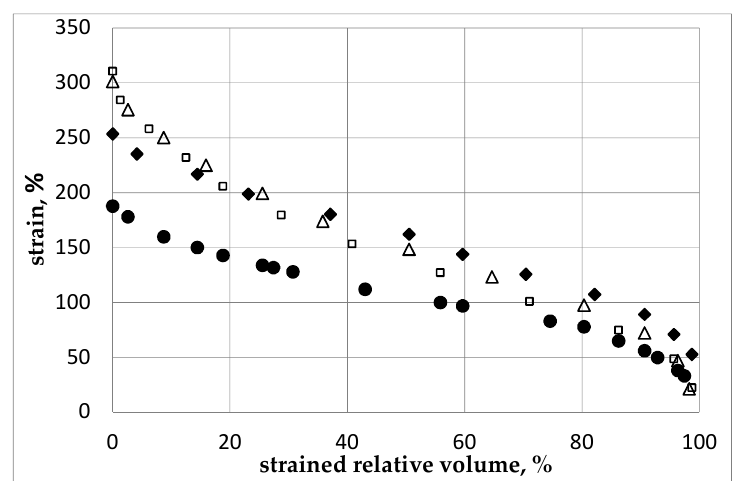
Figure 6. Strain level (%) versus the strained relative volume of sample (%) after the 3rd pass with different rotations relative to the 2nd pass. Black dots ( ● ): optimal ECAP process (Figure 5) with rotation of φ = 90° relative to the 1st pass (В С mode). Open squares ( □ ): billet was not rotated relative to the 2nd pass. Black diamonds ( ♦ ): rotation is φ = 90° relative to the 2nd pass. Open triangles (∆) rotation is φ = 180° relative to the 2nd pass.